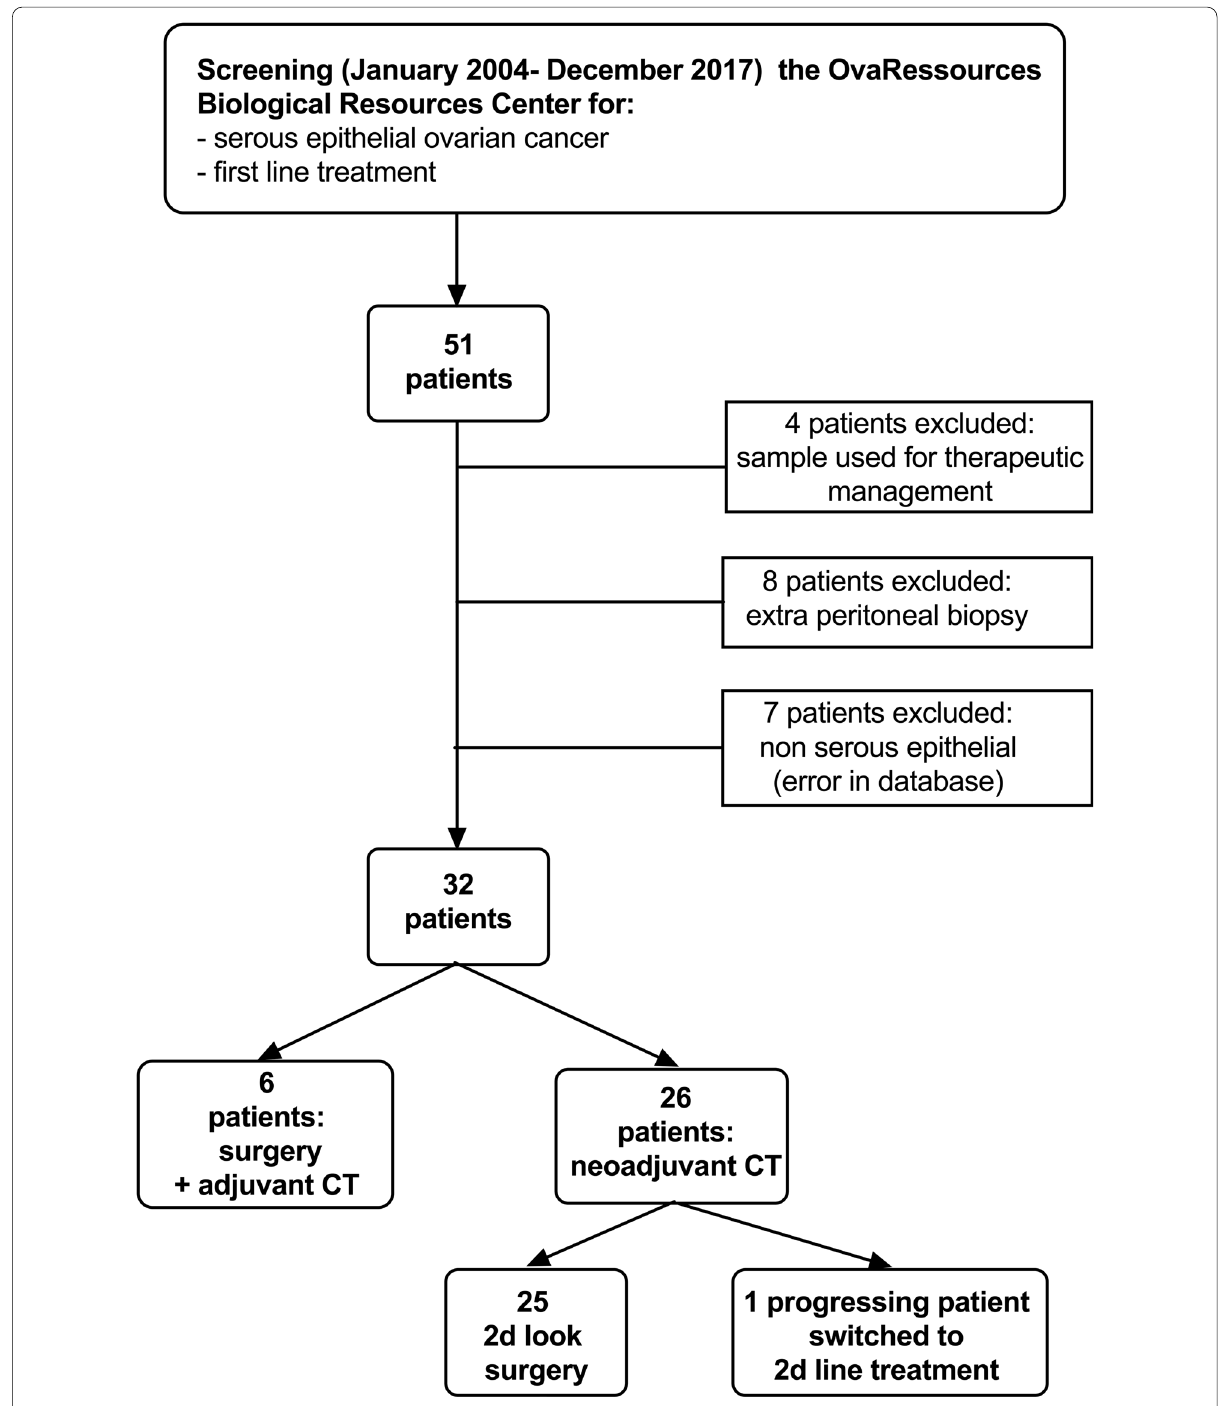
Fig. 1 CONSORT diagram of the study